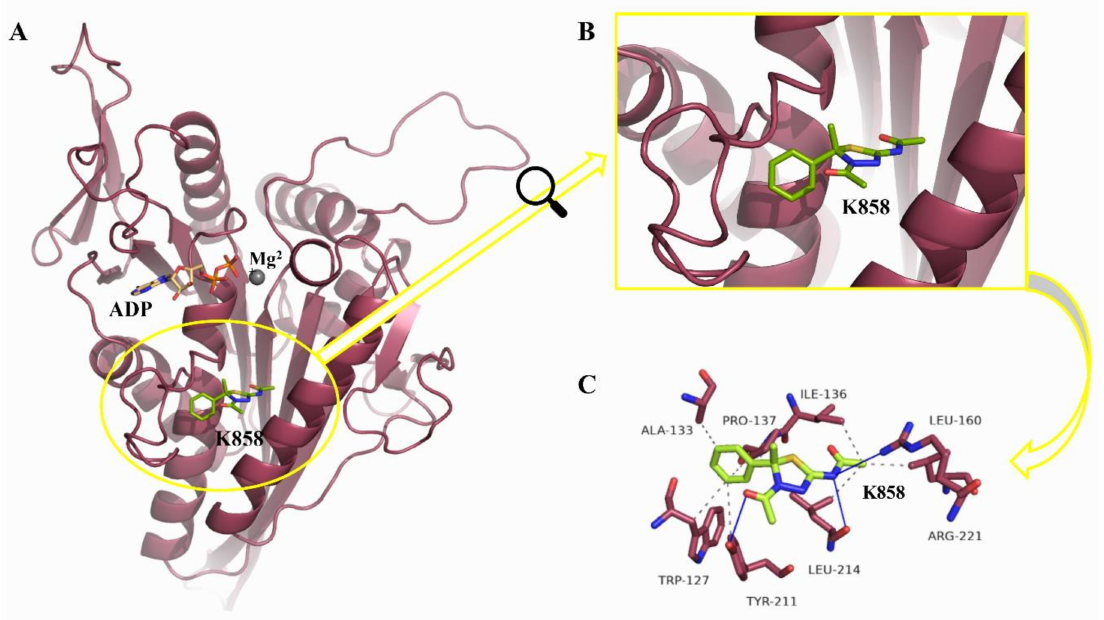
Figure 2. Structure of the K858 -Eg5-ADP complex and zoom on interaction residues. ( A ) Enzyme– ligand complex. The cocrystal structure is from PDB (entry code: 6G6Z), in space groups P6522. The overall structure of the Eg5 motor domain (red cartoon) with Mg 2+ (grey sphere) and ADP (yellow sticks) is bound in the nucleotide-binding pocket. ( S )- K858 (lime sticks), the only active enantiomer of the racemic K858 , is located in the allosteric inhibitor-binding pocket. ( B ) Zoom on the binding site of K858 . ( C ) Interaction residues and K858 . Hydrogen bondings are shown in blue solid lines. Hydrophobic contacts and shown in grey dotted lines. The figure was prepared through Protein-Ligand Interaction Profiler (PLIP) web service [34] and the PyMOL Molecular Graphics System, Version 2.5 Schrödinger, LLC